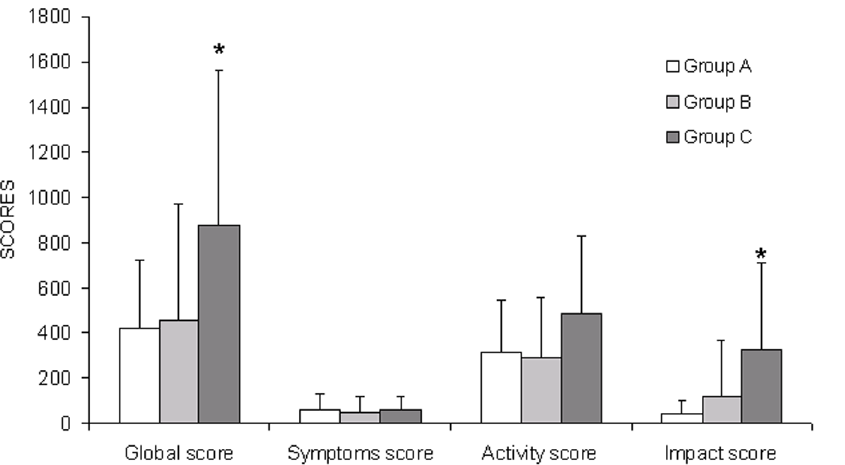
Figure 1. Global score of the Saint George’s Respiratory Questionnaire and score of its ‘‘symptoms’’ component, ‘‘activity’’ component and ‘‘impact’’ component in the 3 groups of patients: group A (patients with no PAVM), group B (patients with ‘‘small’’ PAVMs) and group C (patients with ‘‘large’’ PAVMs). Bars indicate standard deviation.